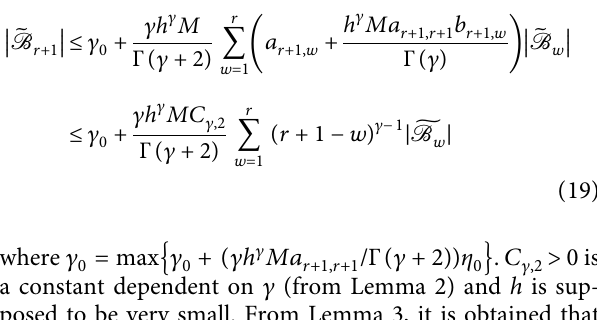
Figure 4: Dynamics of coexisting multiple attractors’ for gradient β (a) State variables x 2 versus x 3 ; (b) state variables x 2 versus x 3